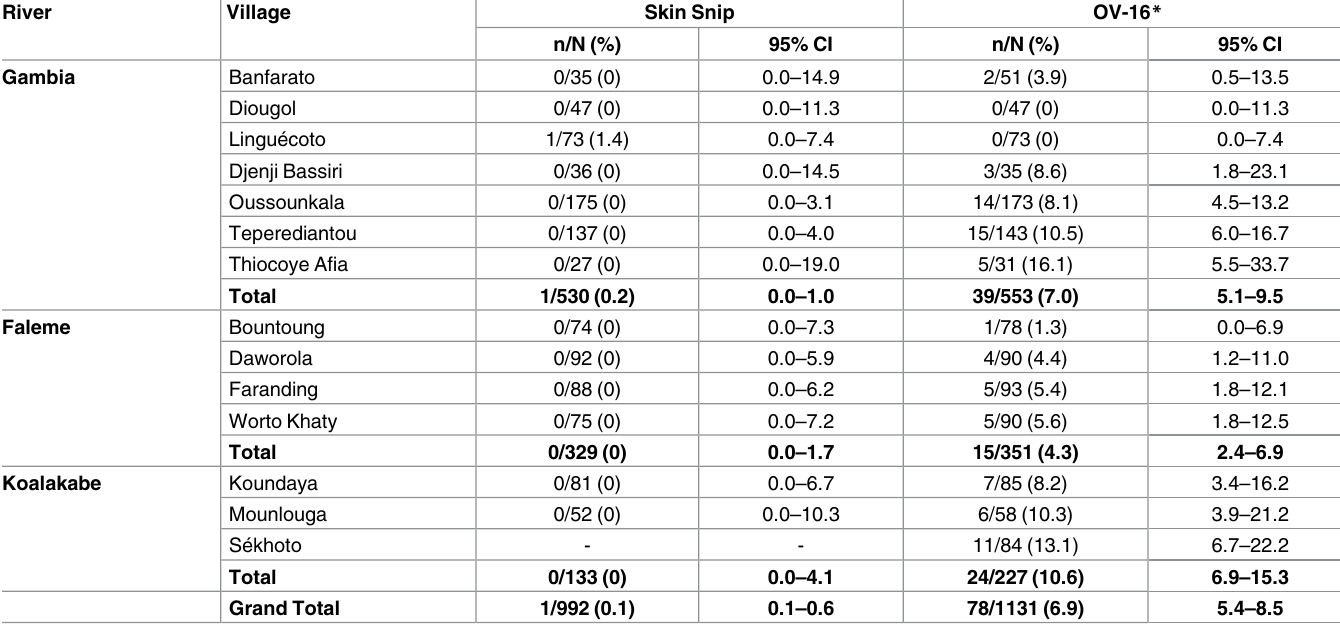
Table 4. Prevalence of onchocerciasis positive results by river and village, Ke´dougou Region River